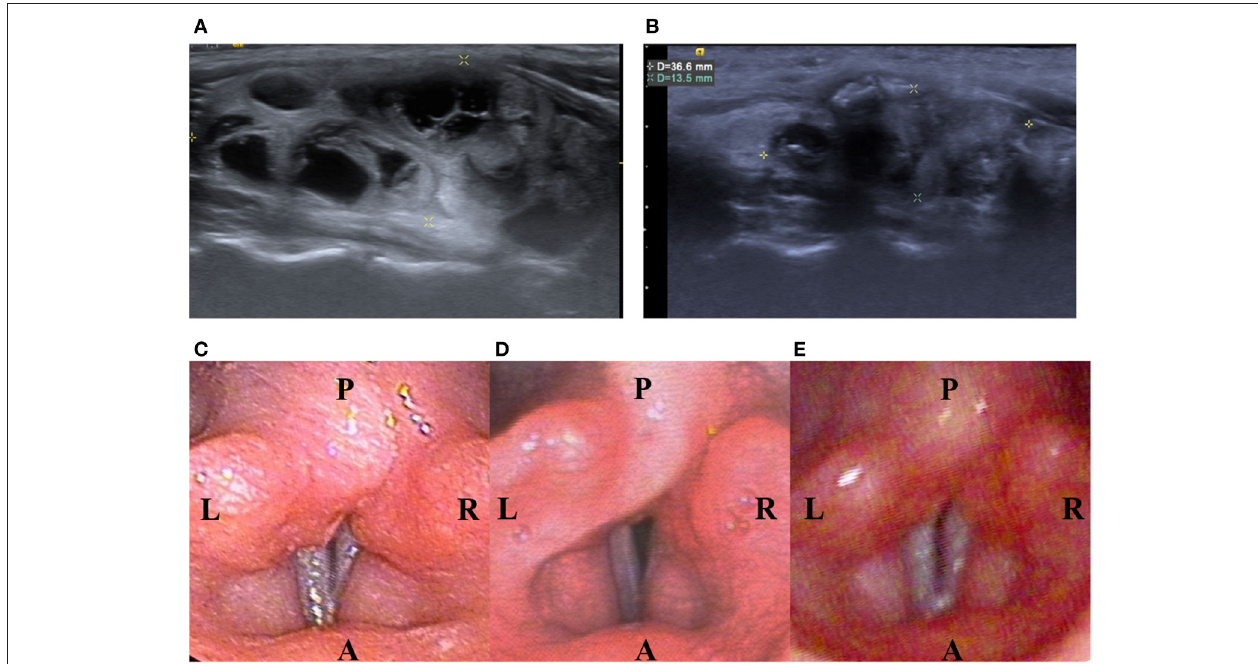
FIGURE 2 | A 13-year-old female patient with a palpable nonfunctioning thyroid mass. (A) Before RF ablation, longitudinal sonographic views predominantly solid nodules in the right thyroid lobe. Initial nodule volume was 22.32mL. (B) At 6 months after the ablation, a longitudinal sonographic view showed that the right thyroid nodule had shrunk. Nodule volume at 6-month follow-up was 4.65mL, a volume reduction rate of 83%. (C) Before RF ablation, laryngoscope showed normal vocal cord. (D) On the same day after RF ablation, laryngoscope showed relative weakness of the right vocal cord but still with positive vibration. (E) On the 53rd day after RF ablation, laryngoscope showed normal vibration of bilateral vocal cord.